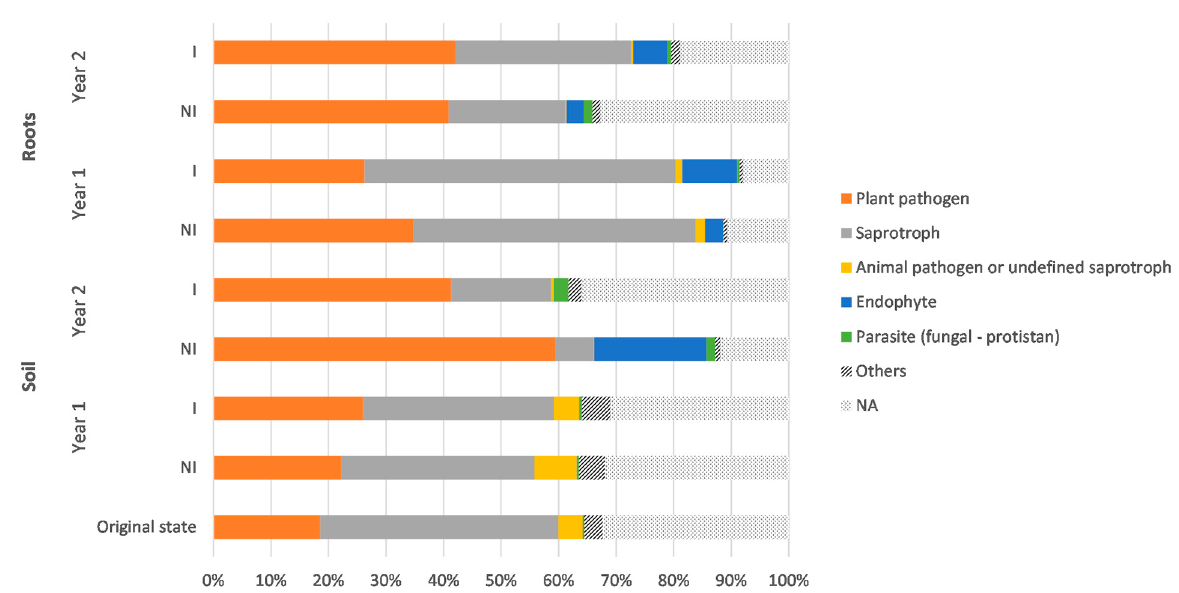
Figure 5. Relative abundances of major fungal functional groups of the ITS rRNA gene data set, according to the different experimental conditions for both root and soil biotopes. The guilds with a relative abundance lower than 0.5% are gathered in the “Others” group. NI: non-inoculated; I: inoculated; NA: non-assigned.